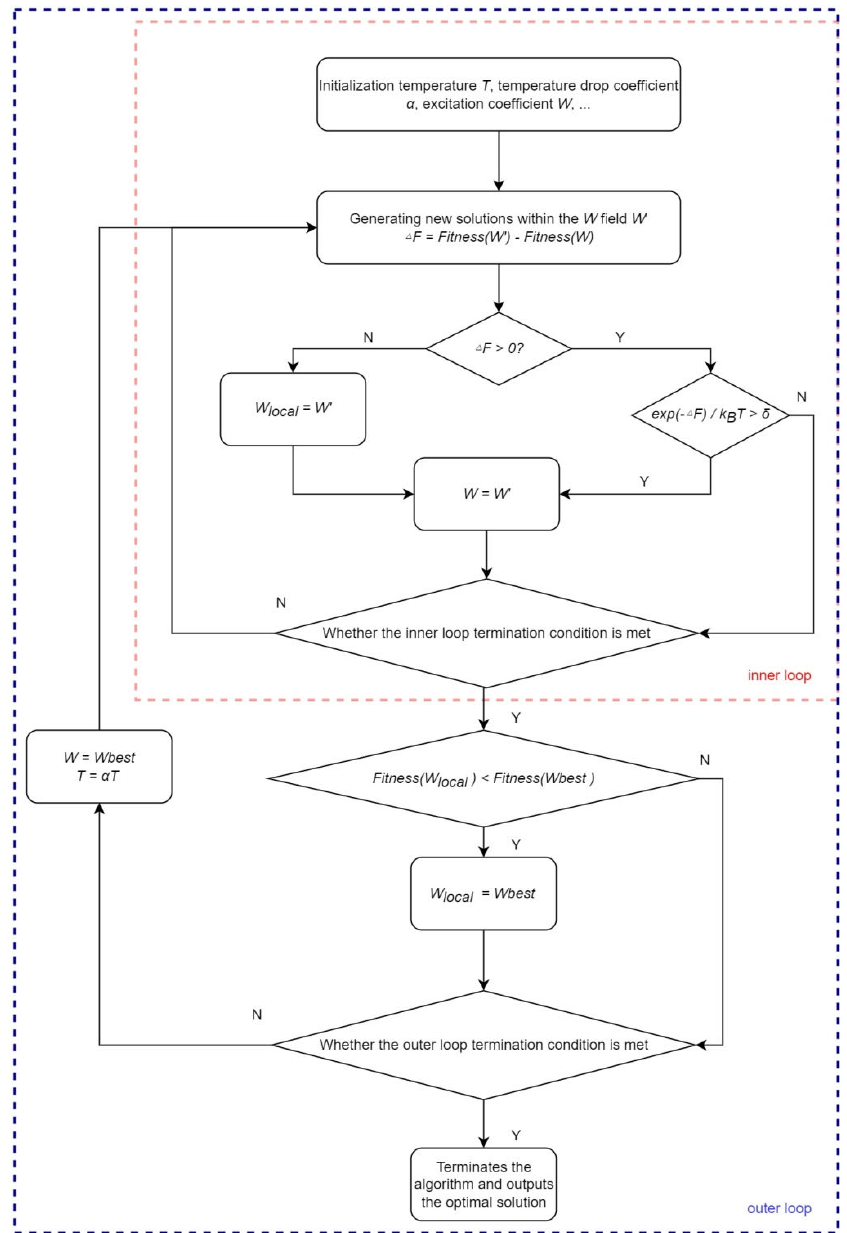
Figure 2. SA algorithm flow chart .